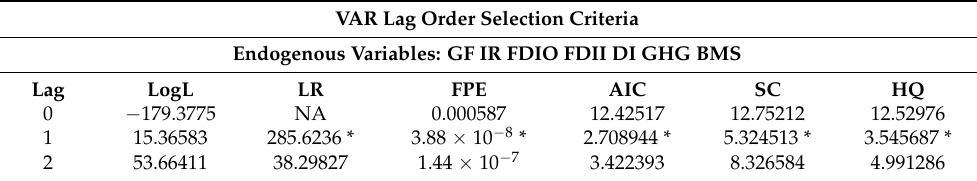
Table 2. The result of lag length criteria. VAR Lag Order Selection